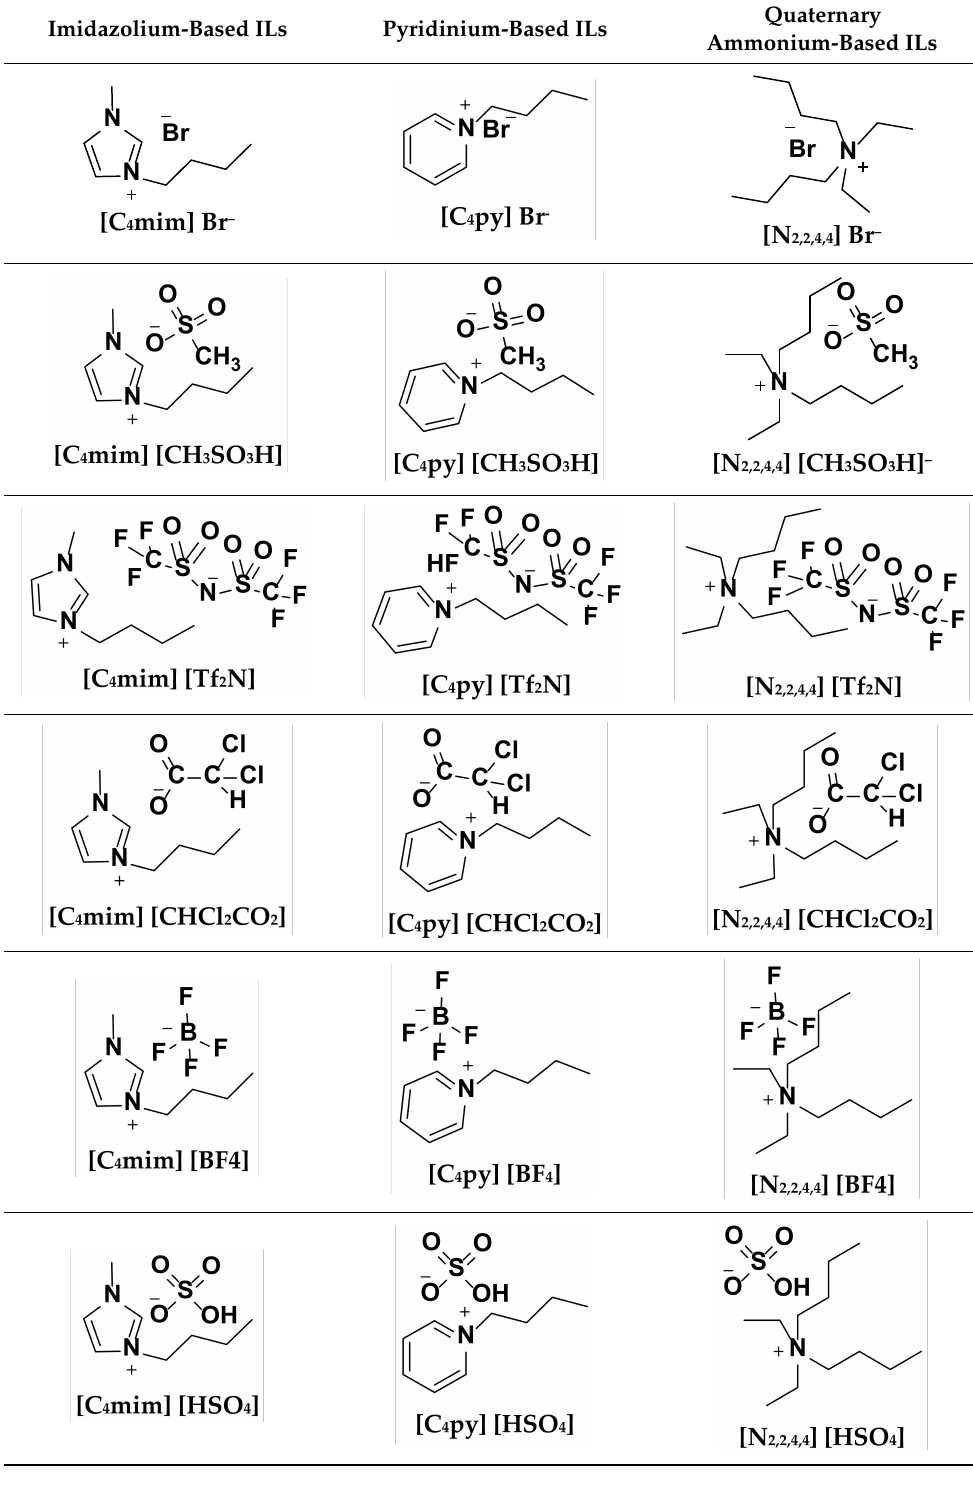
Table 1. Library of ionic liquids synthesized in lab.